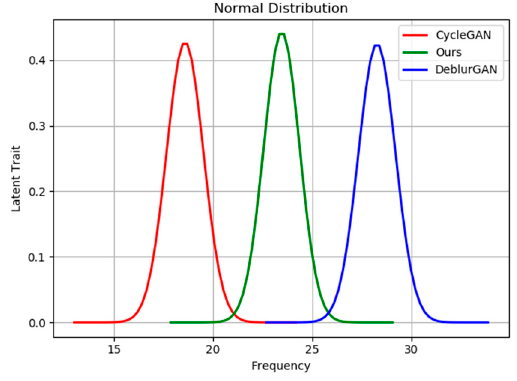
Figure 10. Perceptual test results on unpaired dataset.